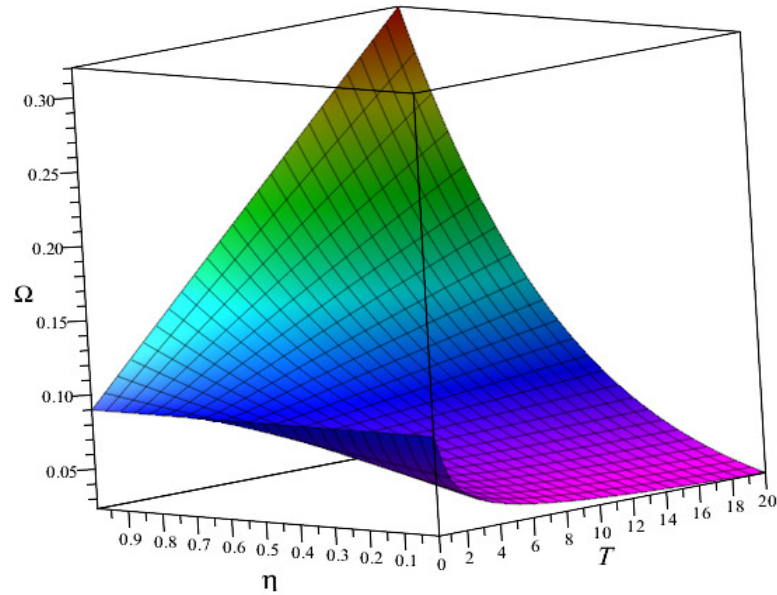
Figure 1. Representation of impact of fractional order ( η ) on the stability condition Ω